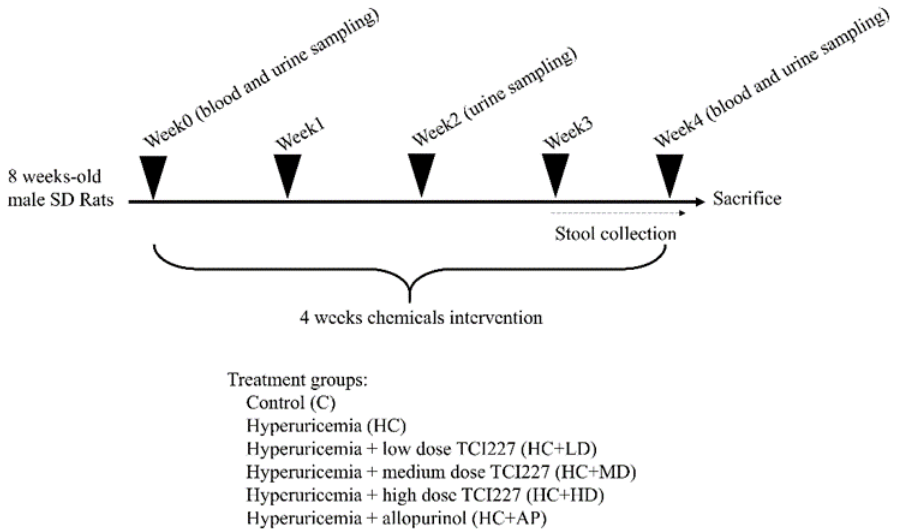
Figure A1. Schematic of probiotic-prevented hyperuricemia progression model.